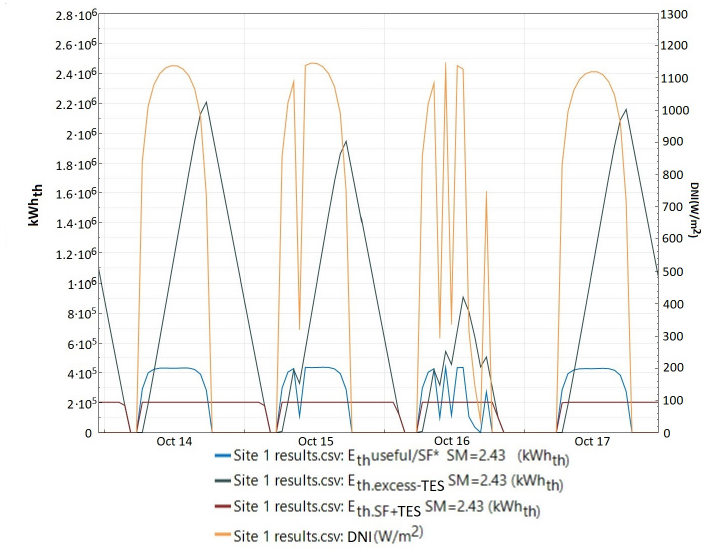
Figure 6. Evolution of the main simulated thermal variables in the presence of moderate and aggressive direct normal irradiance (DNI) transients—site 1 case.